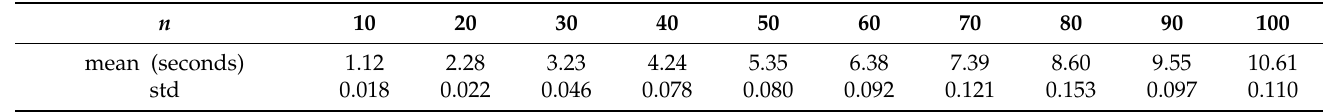
Table 3. Delay introduced by OM processing at n nodes. Average and standard deviation are computed for 30 OMs at each value of n